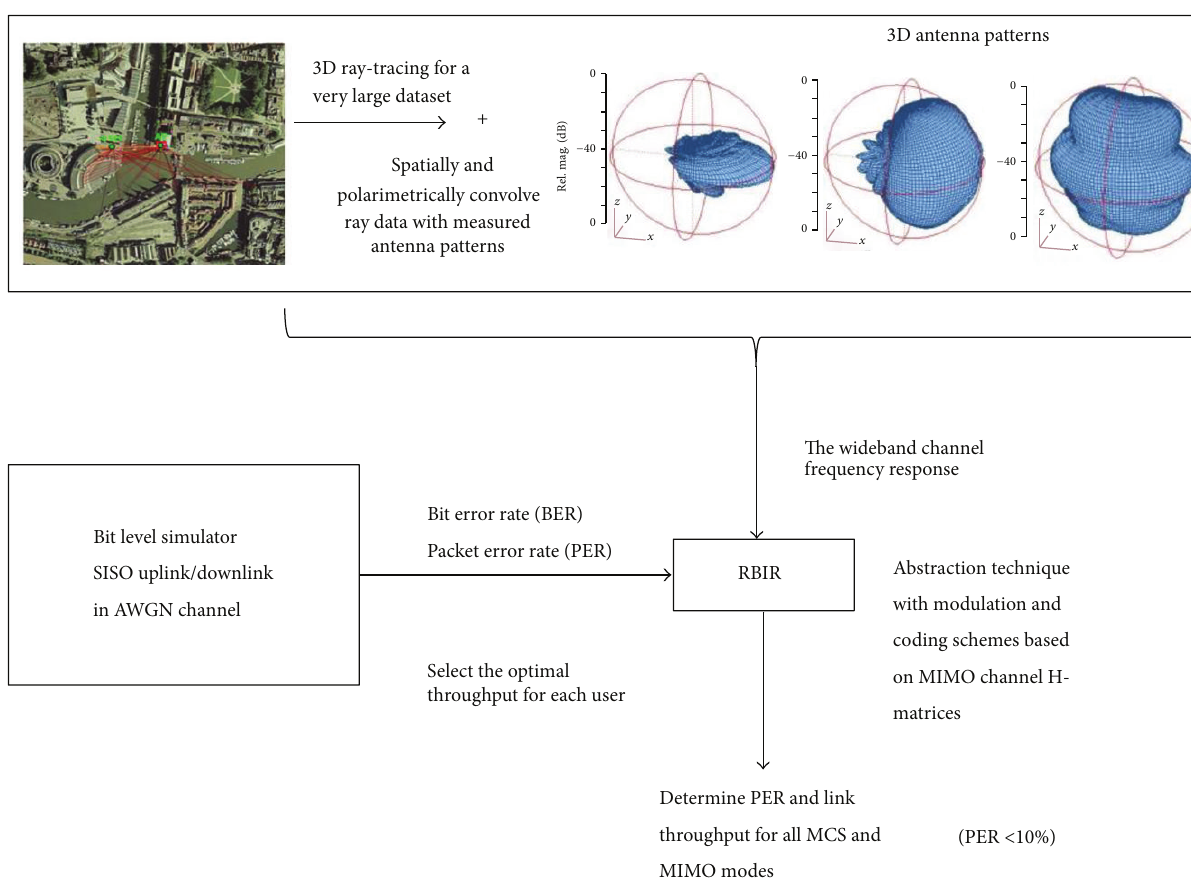
Figure 1: Graphical summary of the modelling